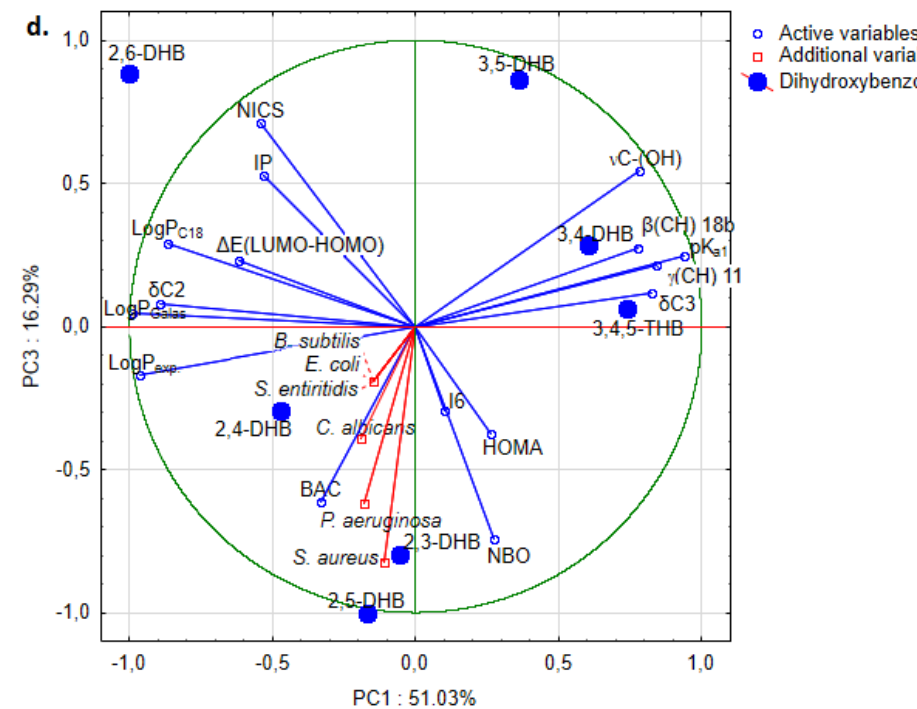
Figure 9. Principal component analysis (PCA) of lipophilic and electronic parameters, aromaticity indices, FTIR and NMR parameters, and the anti-/pro-oxidant ( a , b ) and antimicrobial potential ( c , d ) of the studied compounds.